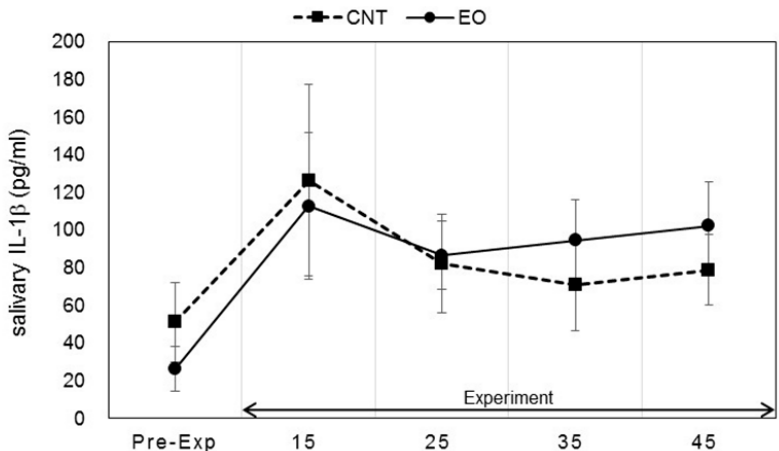
Figure 5. Variation of salivary IL-1 β levels at pre- and during-experiment measurements. The plot in Figure 5 describes changes in the salivary IL-1 β levels of participants in the control (square) and Japanese cedar wood essential oil (experimental; circle) conditions. CNT indicates the control condition, while EO indicates the experimental condition. Differences between conditions were not significant. Data are shown as mean ± SEM.